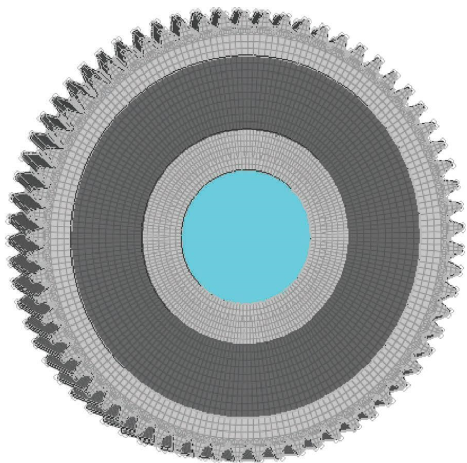
Figure 3: Schematic of a gear fnite element